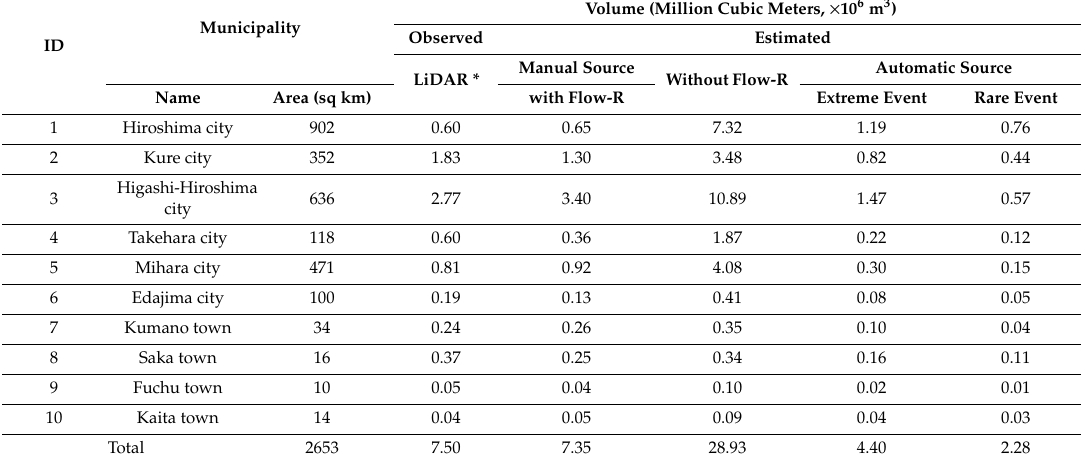
Figure 13. ( a ) Comparison of volume estimations with and without using Flow-R-based propagation analysis. ( b ) Comparison of volume estimations based on manual sources and automatic sources in Flow-R analysis.